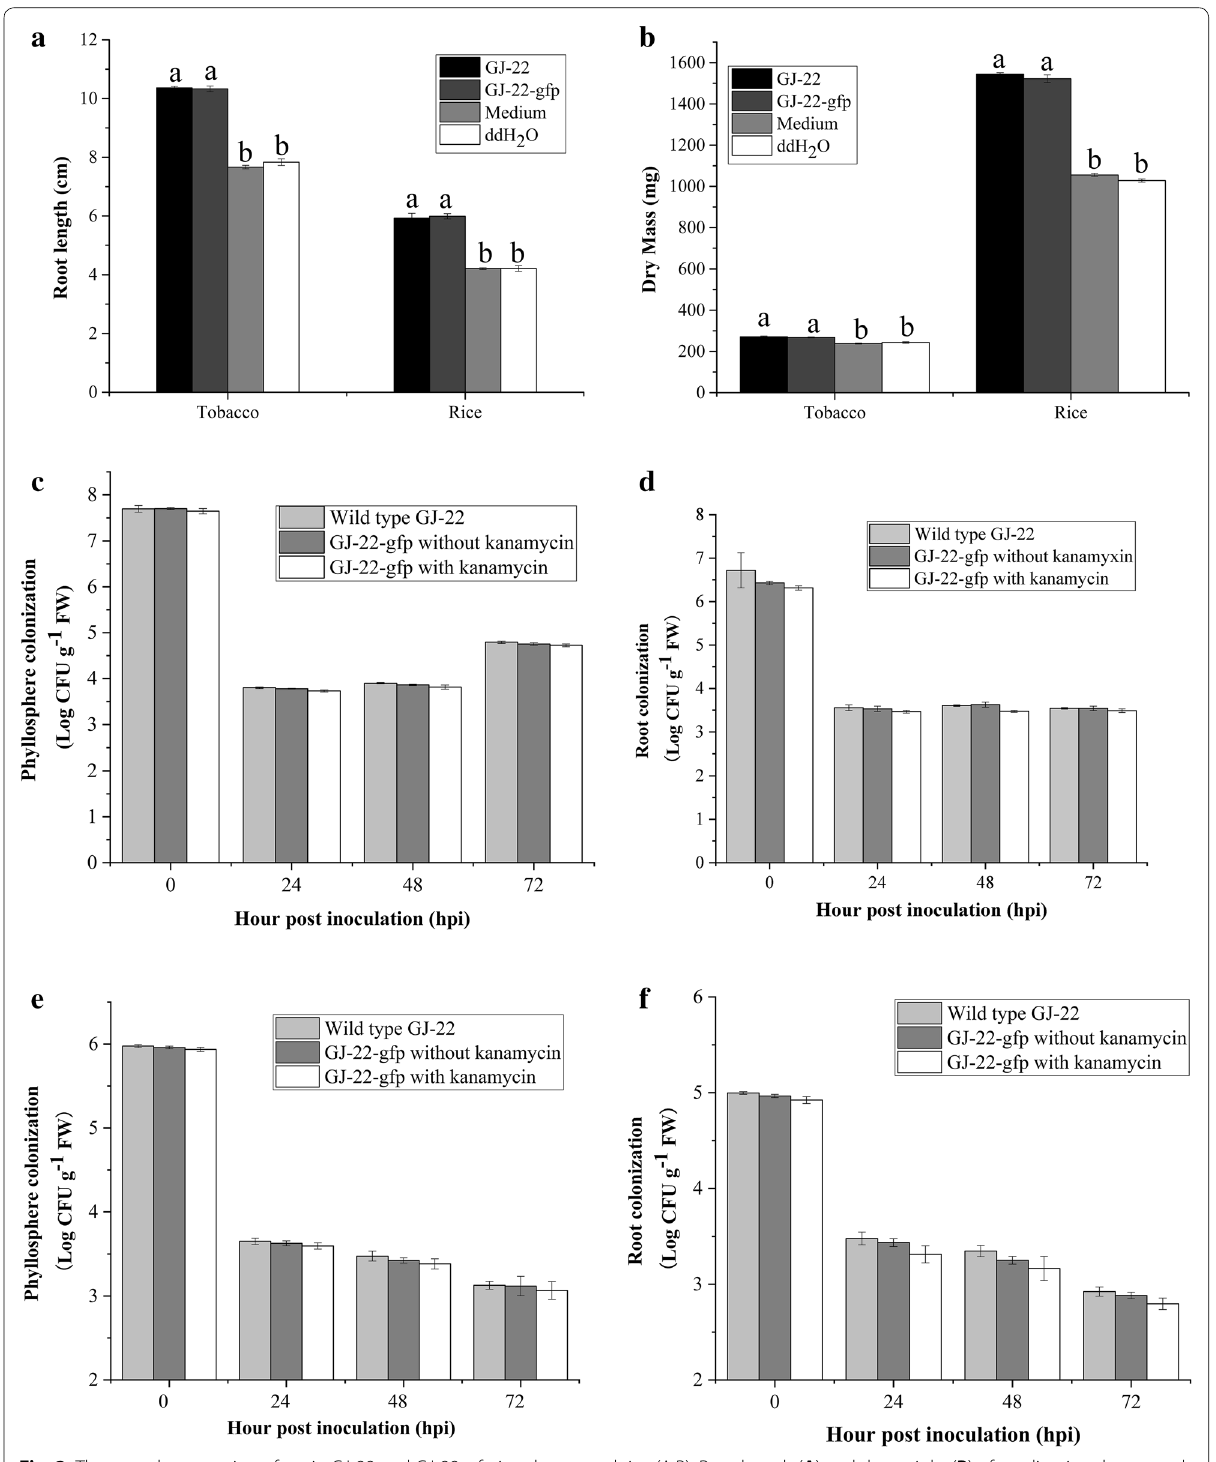
Fig. 3 The growth promotion of strain GJ-22 and GJ-22-gfp in tobacco and rice (A,B). Root length ( A ) and dry weight ( B ) of seeding in tobacco and rice inoculated with four treatments. GJ-22, GJ-22-gfp, medium and ddH 2 O. And the different letters indicate significance of treatments (P < 0.05). The population of strain GJ-22 and GJ-22-gfp colonised on the phyllosphere and rhizosphere of tobacco ( C , D ) and rice ( E , F ). The strain GJ-22 were cultured on the agar medium without kanamycin, and the strain GJ-22-gfp were cultured on the medium with and without kanamycin respectively (P >